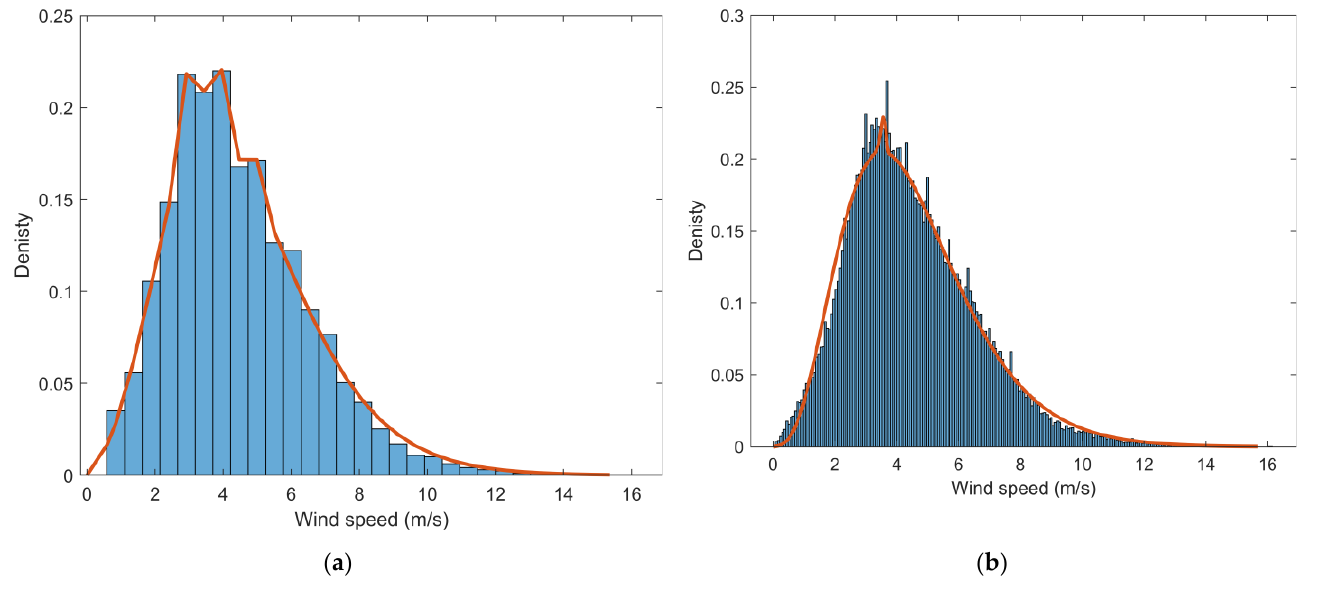
Figure 7. Fitting wind data of Site 5 to 𝑓 𝑚𝑖𝑥 using MOPSO: ( a ) 30 equal wind speed spacings; ( b ) variable wind speed spacings.